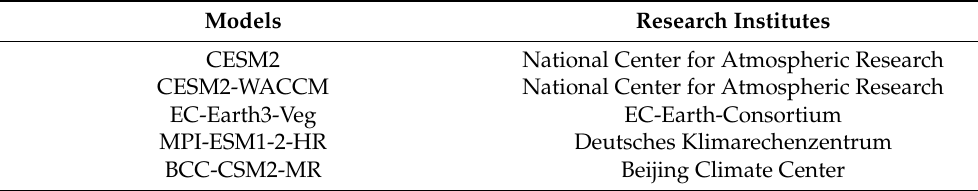
Table 1. Introduction of models with the same spatial resolution of 100